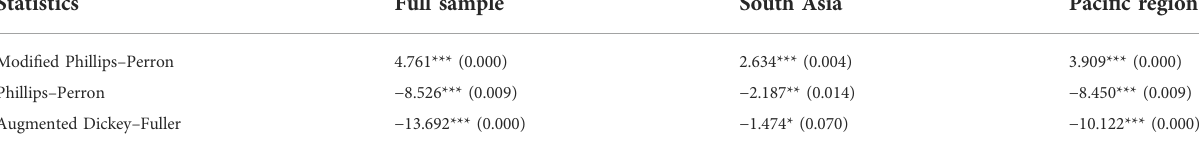
TABLE 4 Results of the Pedroni cointegration